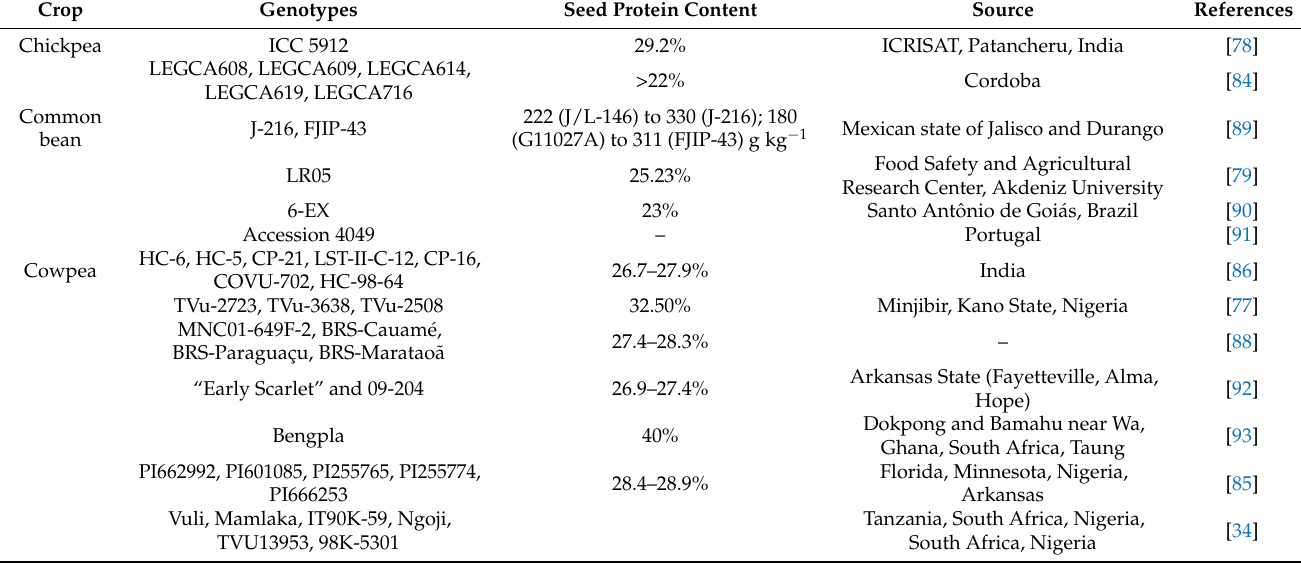
Table 2. List of various legume genotypes with improved seed protein